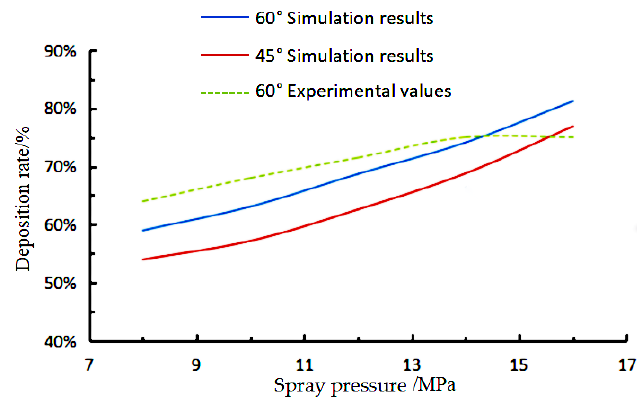
Figure 25. Relation between paint deposition rate and spray pressure.